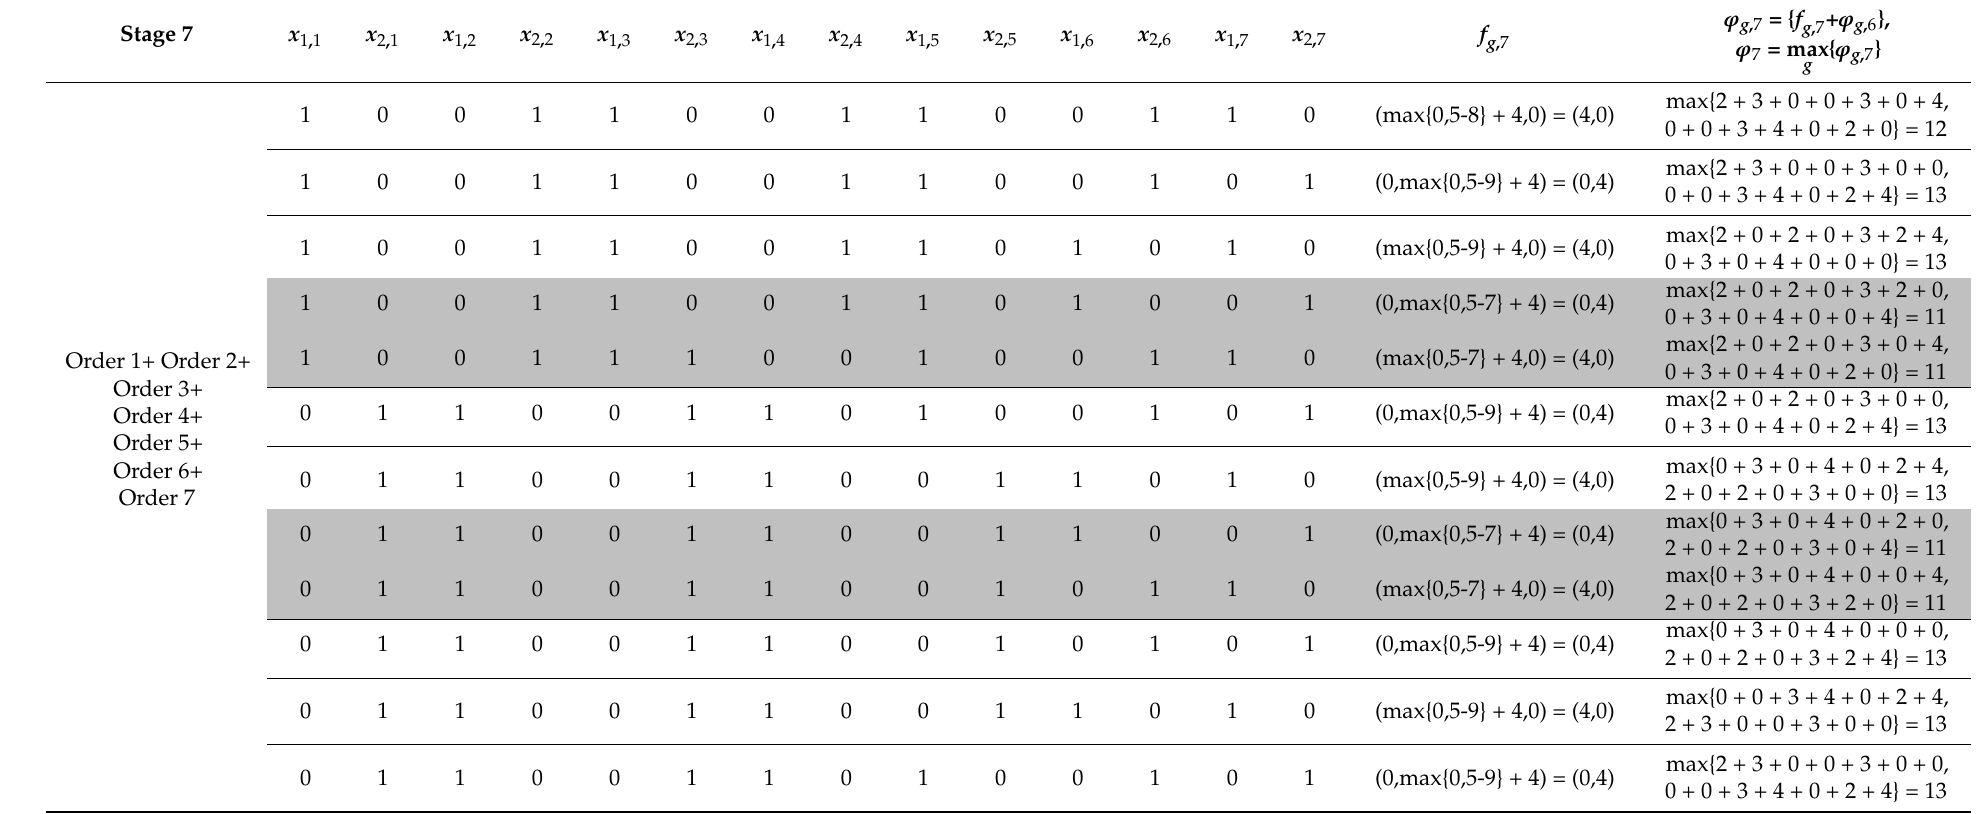
Table 3. Results of the last algorithm stage